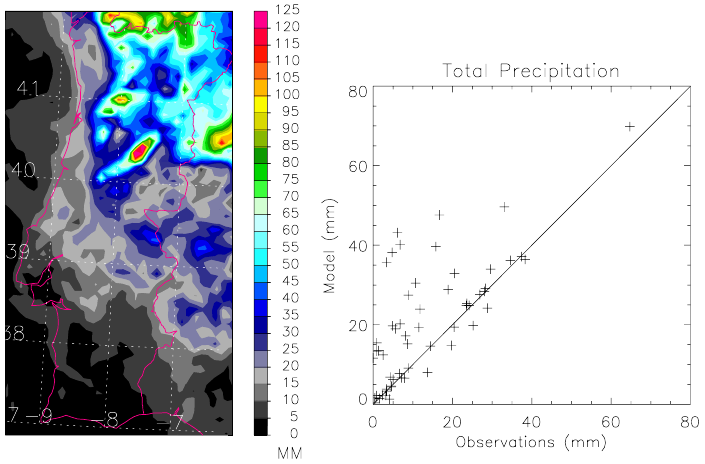
Fig. 3. Accumulated precipitation, in mm, from 30 May to 20 June 2002 obtained from the simulations (left) and scatter plot of the total accumulated precipitation rain gauge measurements versus model data at the nearest grid point (right).